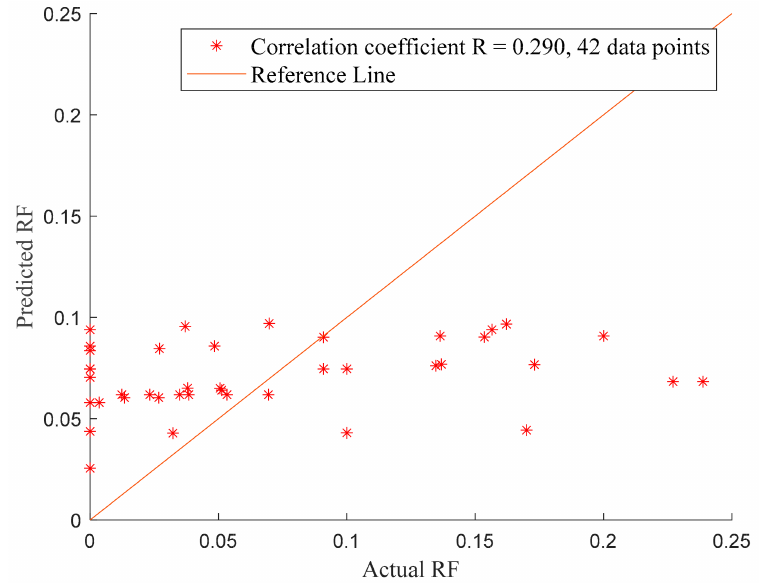
Figure 3. Predicted RF from linear regression and actual RF from experiments for oil/brine parame- ters (Predicted RF = 0.023 − 0.158 × DC − 0.0058 × AB + 0.091 × DTDS − 0.48 ×